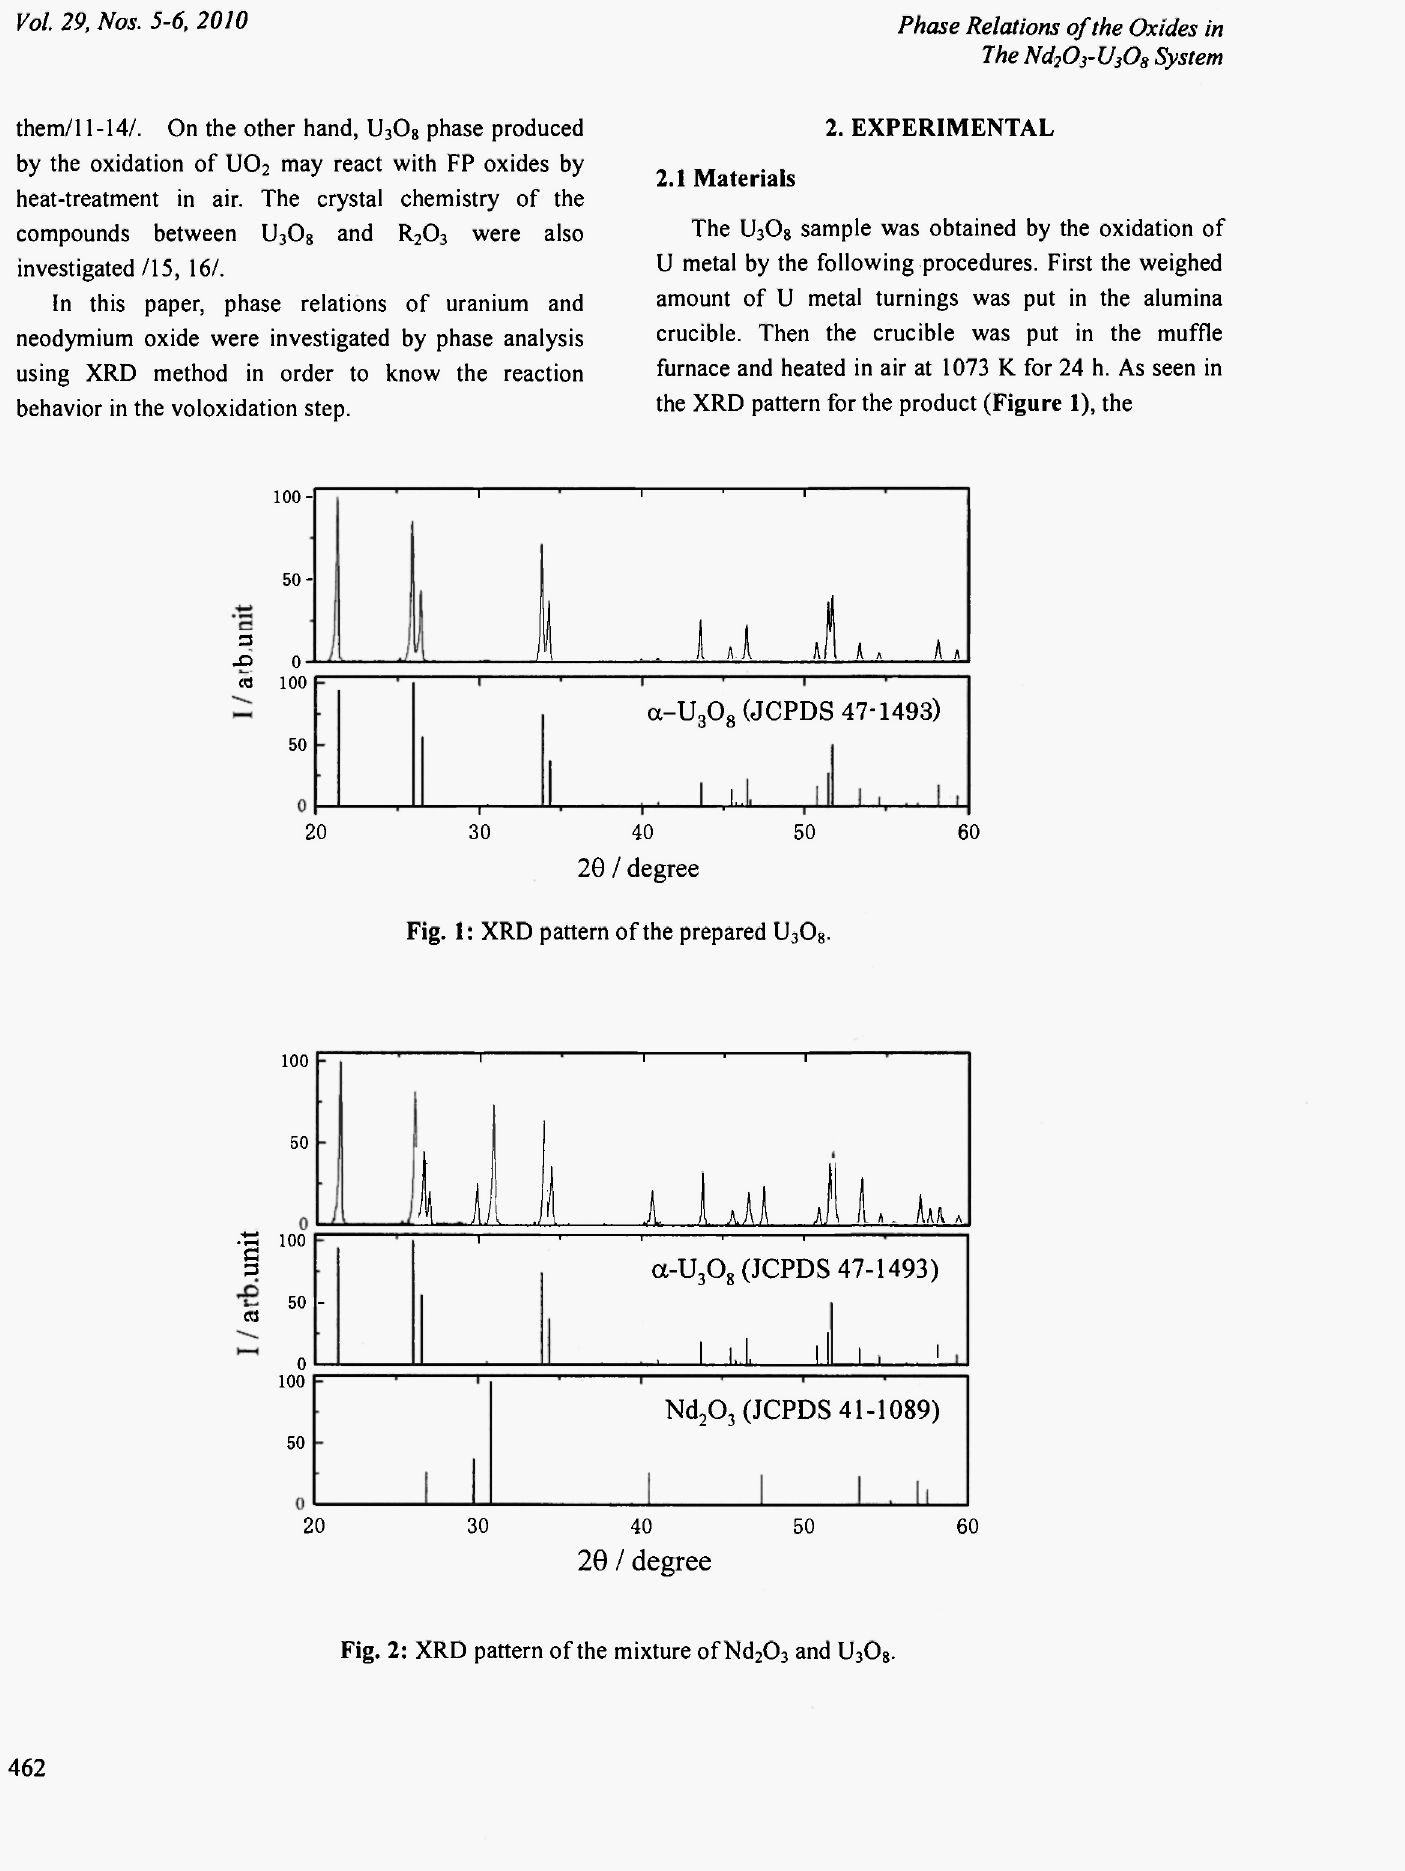
Fig. 2: XRD pattern of the mixture of Nd 2 0 3 and U 3 0 8